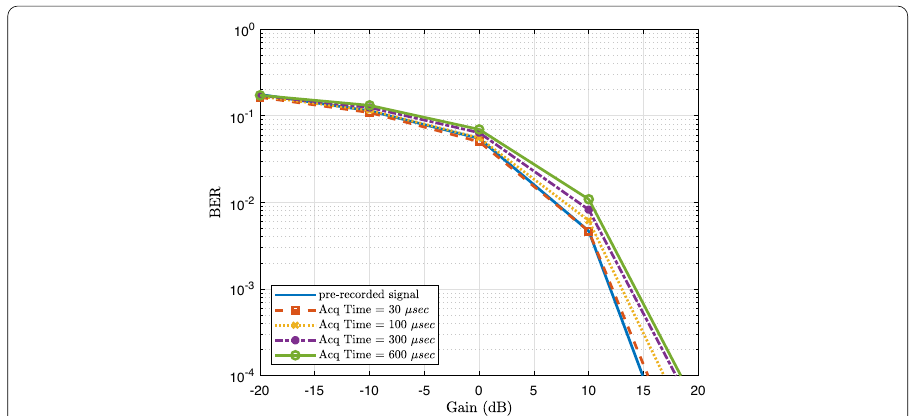
Fig. 15 Acquisition time impact on the model